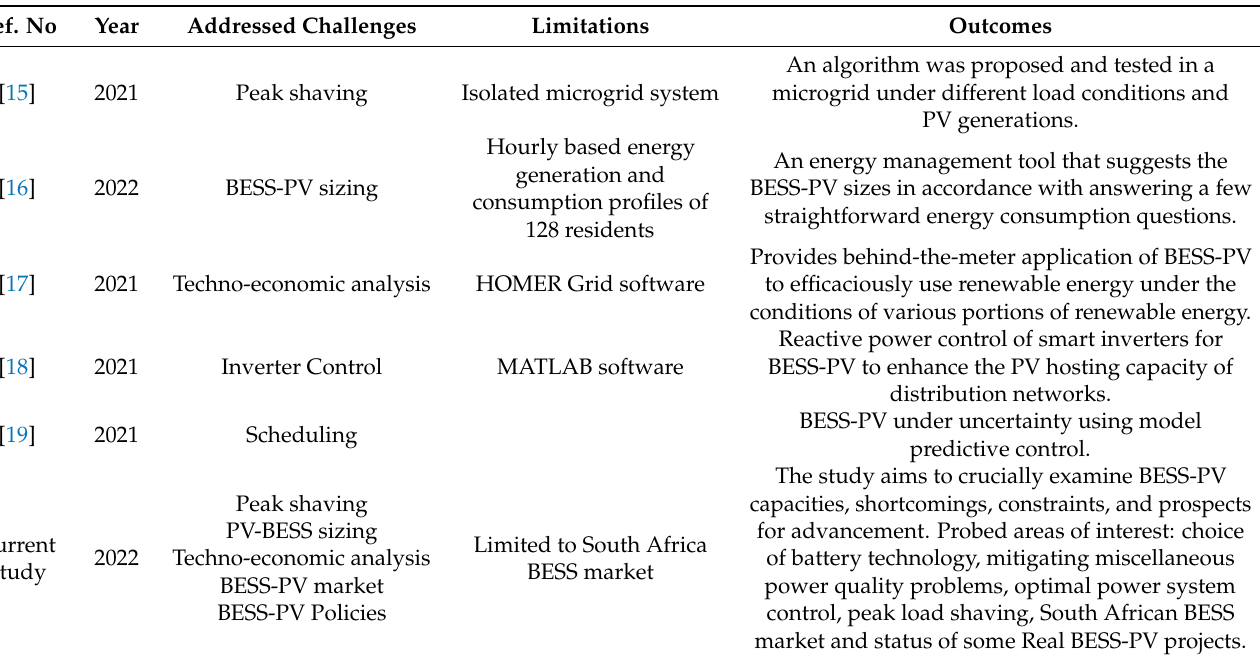
Table 1. Summary of recent related research works.